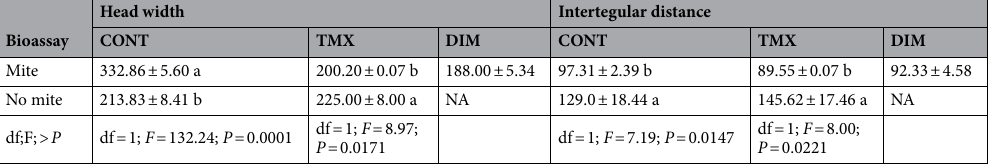
Table 3. Summary of Scaptotrigona postica morphometric data. Means followed by the same letters do not differ from each other by the t test (LSD—minimum significant difference), with Bonferroni protection (α = 0.05). NA No